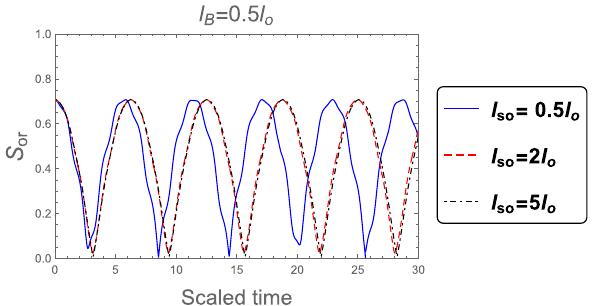
l so 0.5 l o , 2 l o , and 5 l o when : =